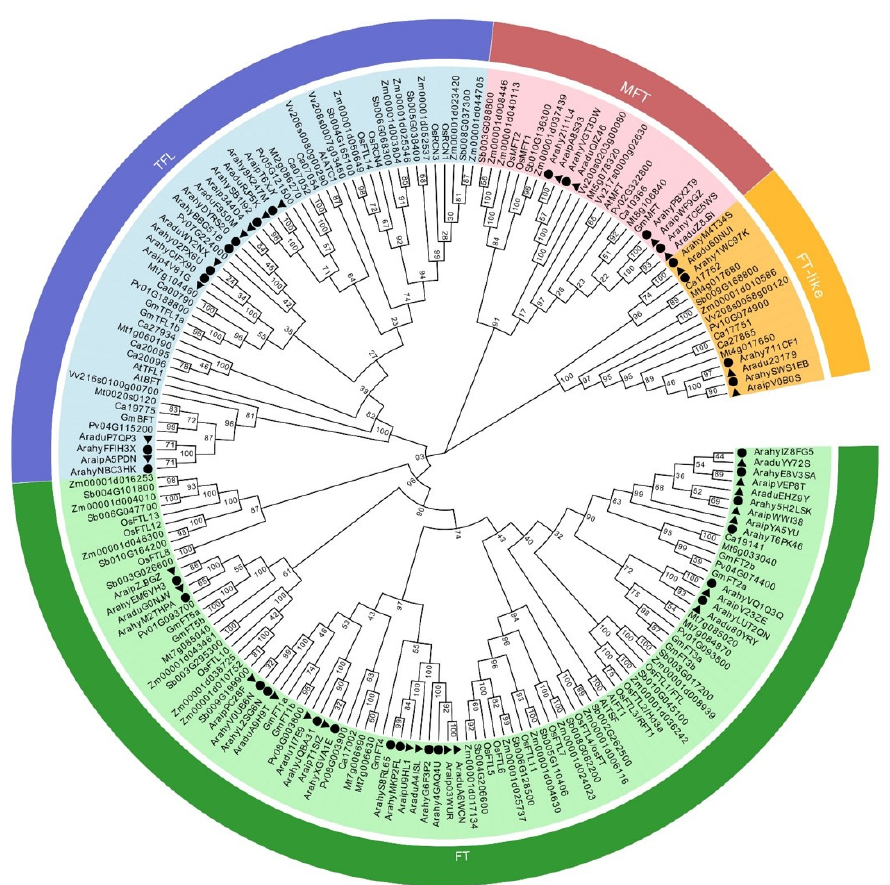
Figure 5. Neighbor-joining phylogenetic tree constructed based on 188 PEBP proteins of soybean, chickpea, alfalfa, common beans, Arabidopsis, grapes, rice, sorghum and maize as well as three Arachis species. The PEBP genes were divided MFT, FT and TFL and FT-like subgroups. PEBP proteins in cultivated and wild peanuts are marked by black dots and triangles, respectively. The phylogenetic tree is built using the complete amino acid sequences of the PEBP proteins by MEGAX with the Neighbor-joining method (Bootstrap =